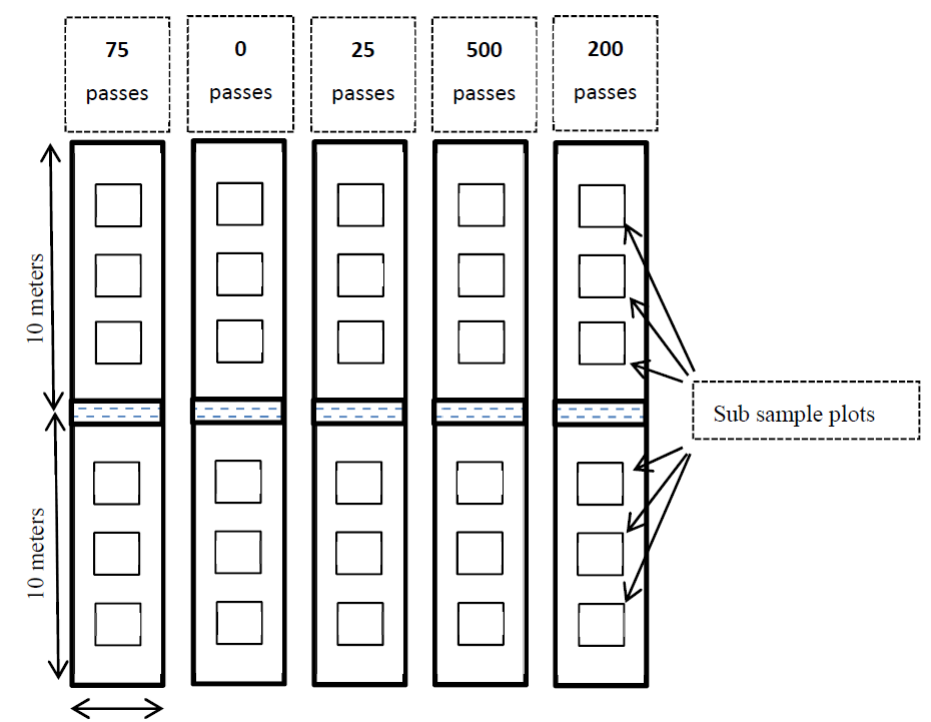
Figure 2. The design of the experimental plots used in each study area (modified from a previous study